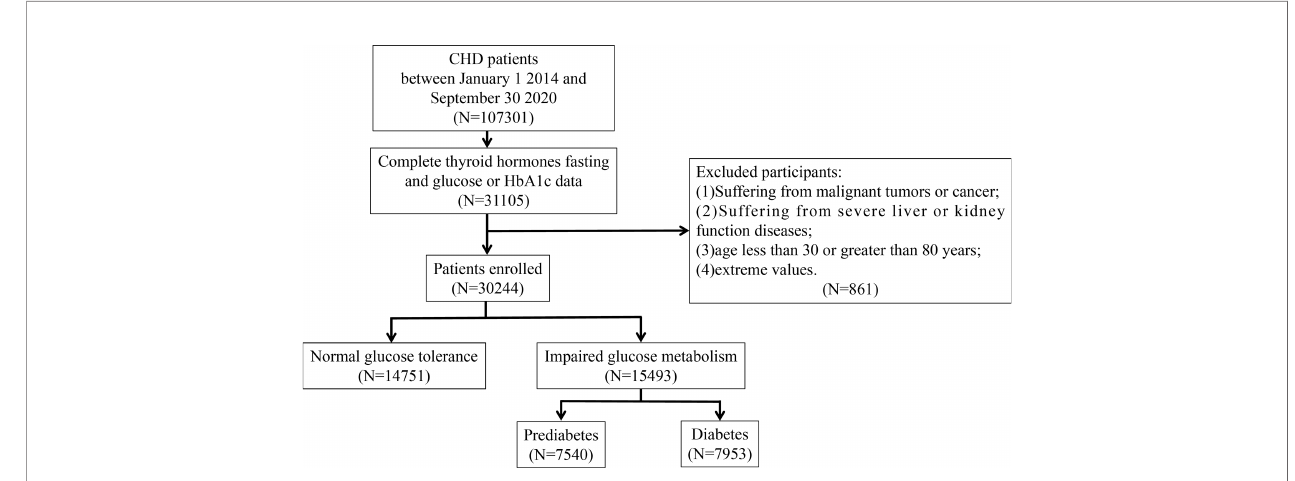
FIGURE 1 | Flowchart of patient